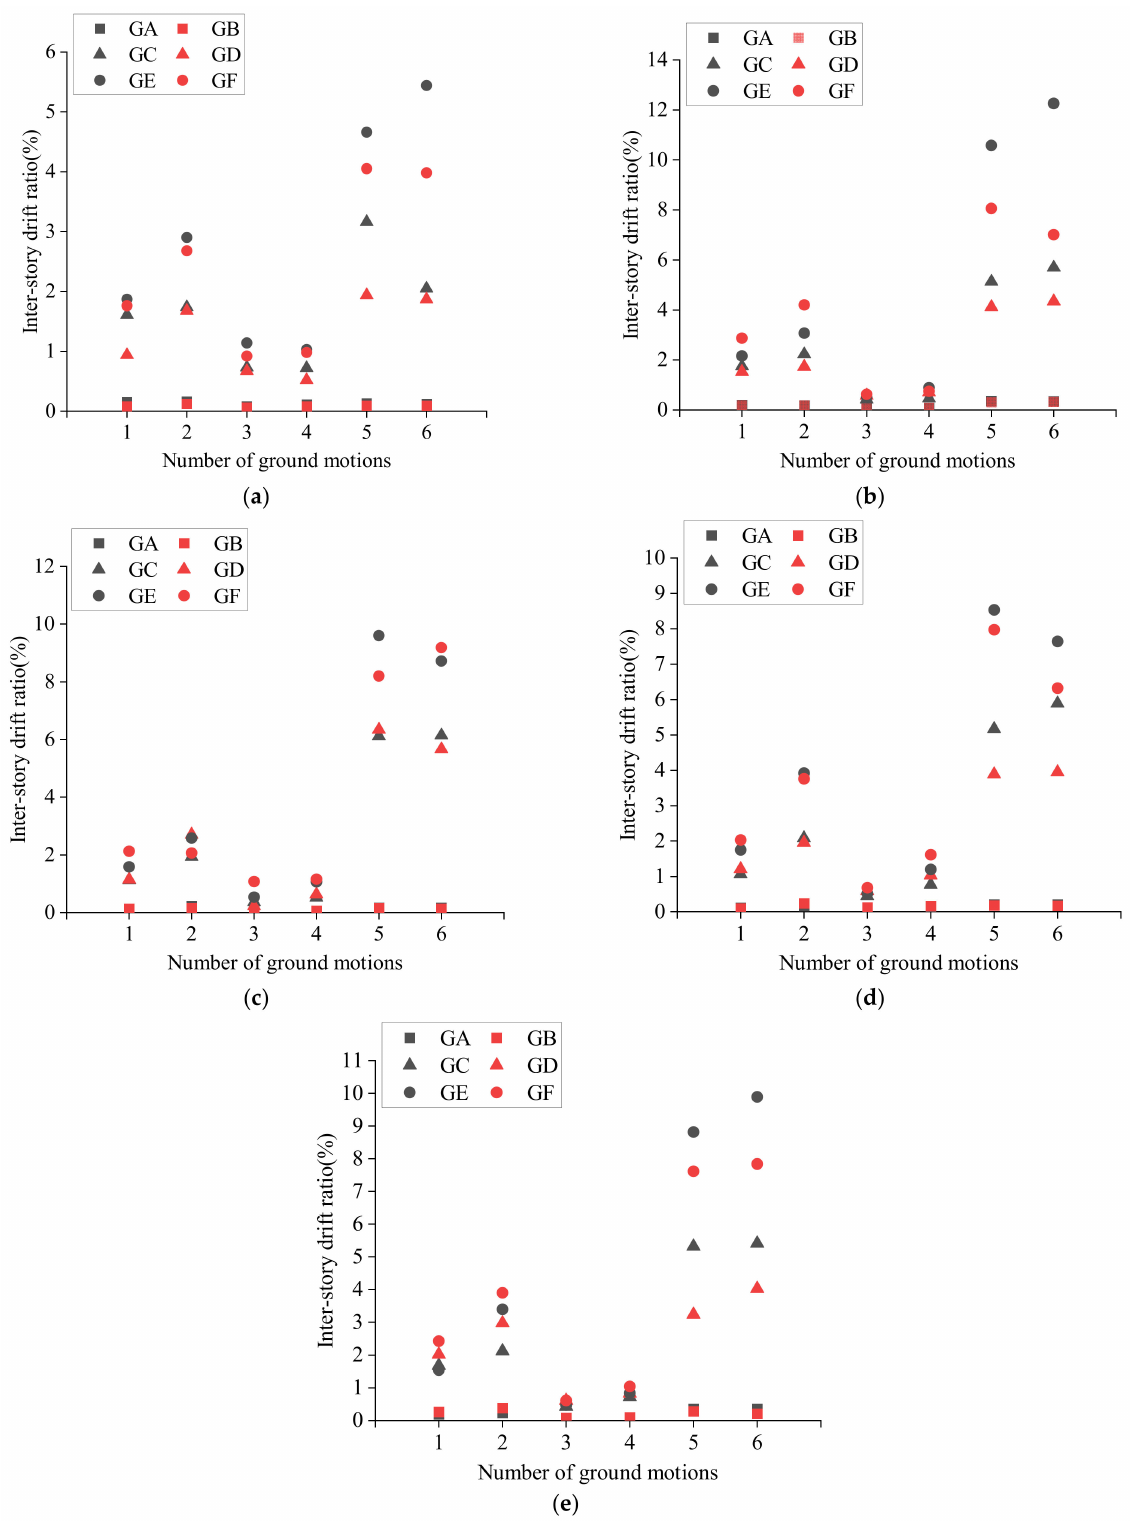
Figure 5. Validation of the MCS-model-based method (maximum IDR): ( a ) 3-story structure; ( b ) 5- story structure; ( c ) 8-story structure; ( d ) 12-story structure; ( e ) 18-story